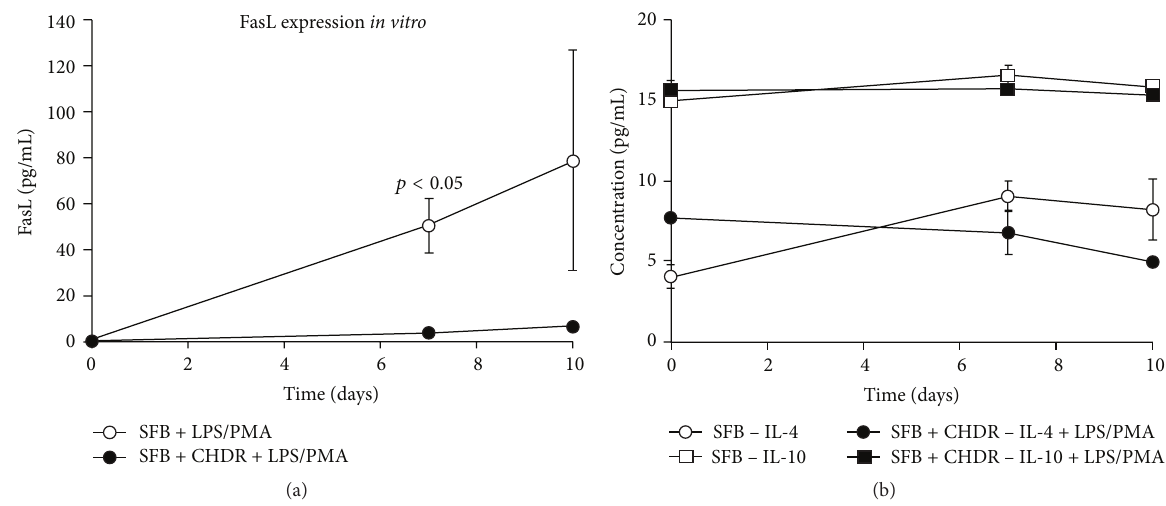
Figure 4: (a) shows FasL levels in the in vitro coculture. Concentrations increased over time in both groups but were statistically significantly more elevated in the group without CHDR. (b) illustrates IL-4 and IL-10 levels. We observed no dependency on time or presence of